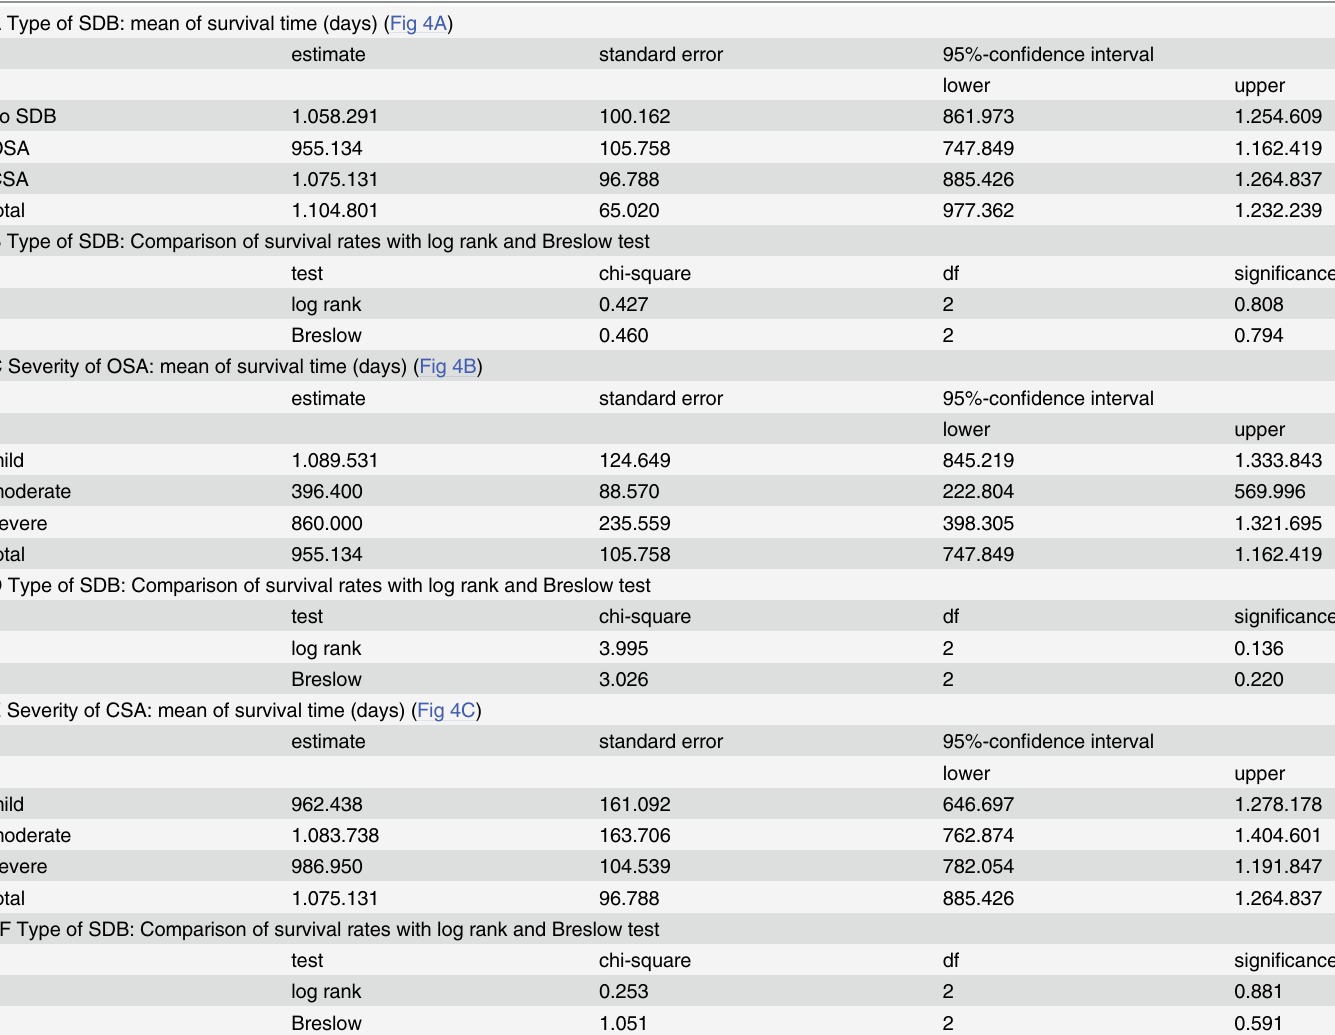
Table 3. Statistics of survival